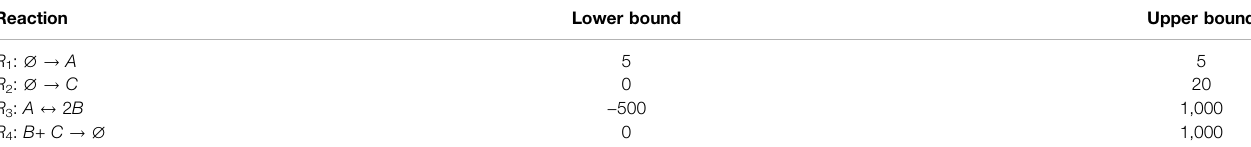
Reaction Lower bound